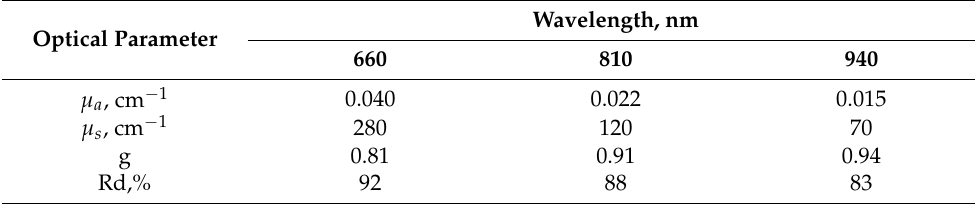
Figure 8. ( a ) The design of the developed measure of arterial blood flow with a peripheral tissue optical probe placed on it: 1—measure, 2—F-4 base, 3—optical absorption filter film, 4—PDLC film, 5— ac electrical signal generator, 6—peripheral tissue optical probe, 7—LEDs, 8—photodiode; ( b ) photographs of the measure prototype with (left) and without (right) peripheral tissue optical probe b ) photographs of the measure prototype with ( left ) and without ( right ) peripheral tissue optical placed on it. ( probe placed on it. Table 3. Optical properties of the fluoroplastic F-4 measure base. Optical